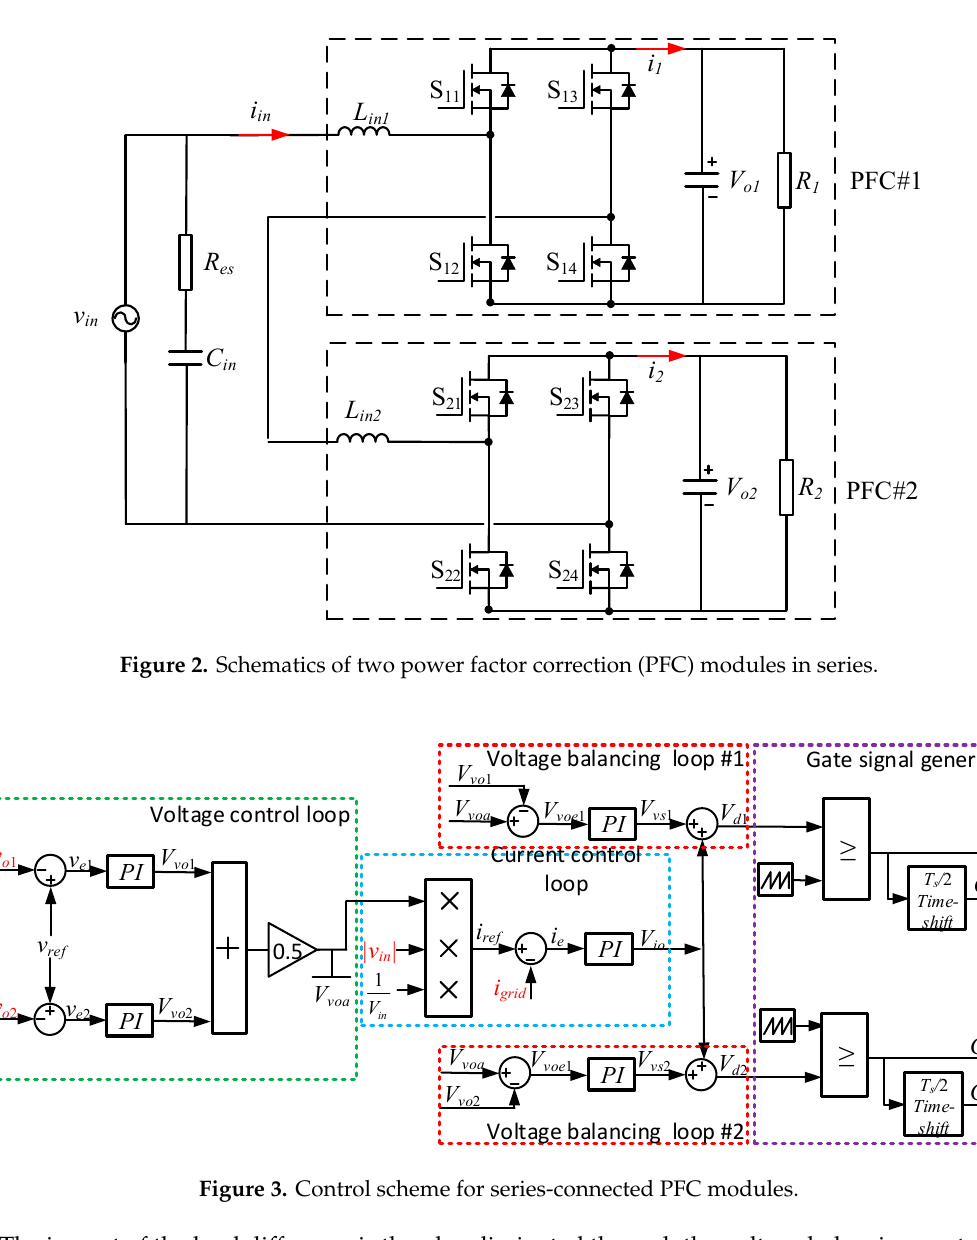
Figure 3. Control scheme for series-connected PFC modules.